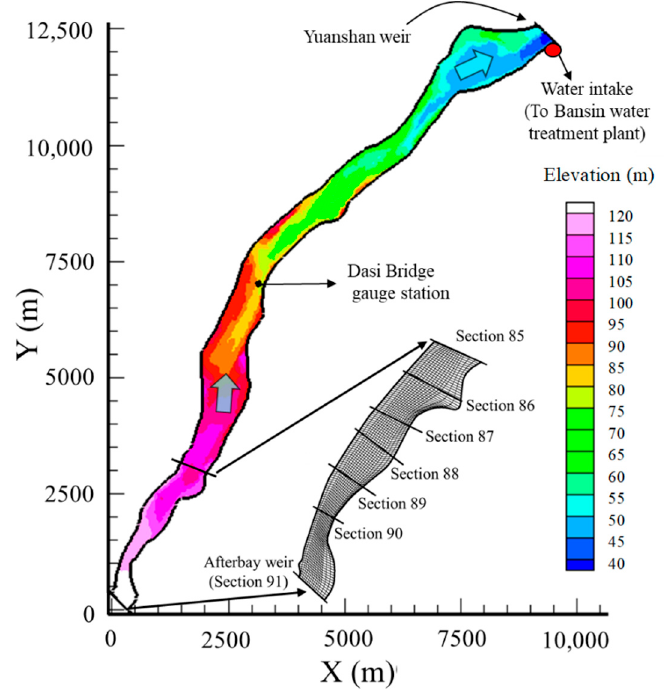
Figure 3. Simulation domain along the downstream river from Shihmen afterbay weir to Yuanshan weir; some of the grid meshes also displayed.